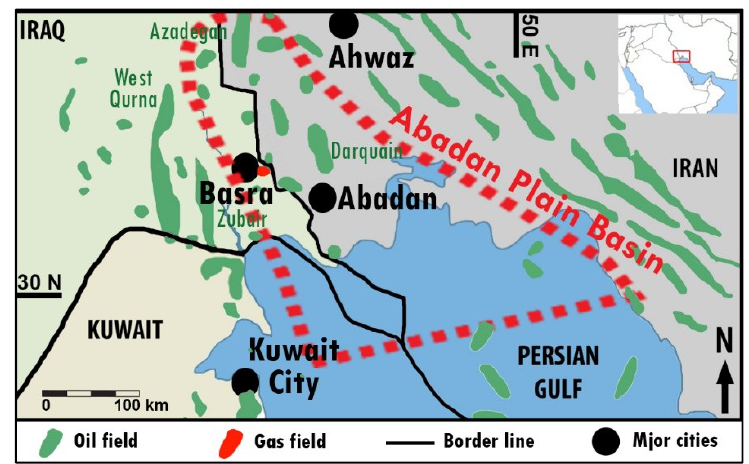
Figure 1. Abadan Plain Basin and oil and gas fields in the region. Abadan Plain Basin is the area within the dashed red polygon.